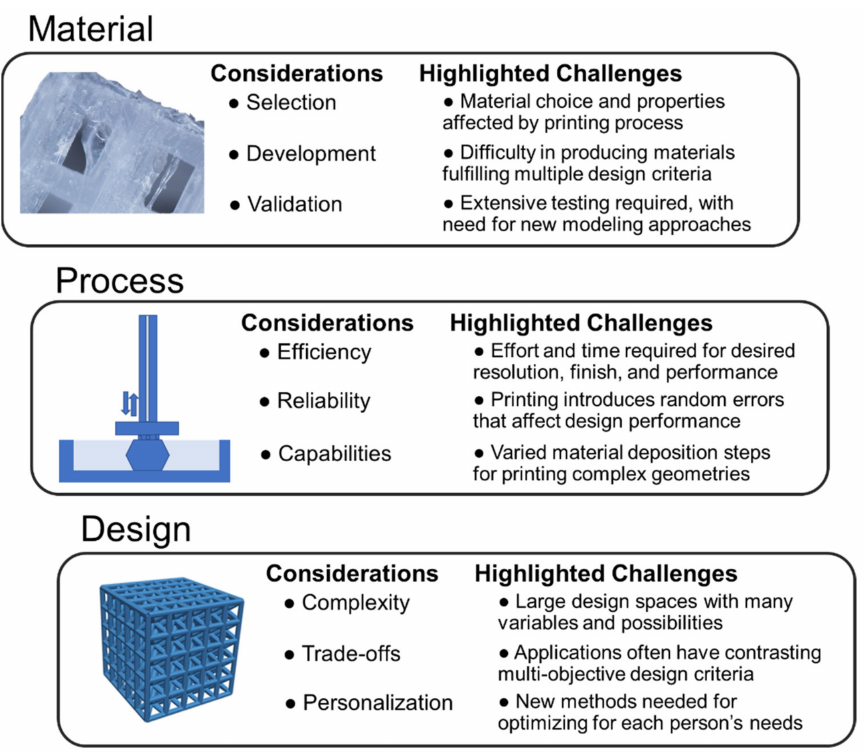
Figure 6. Key research challenges for 3D printing polymers using materials, process, and design strategies for medical